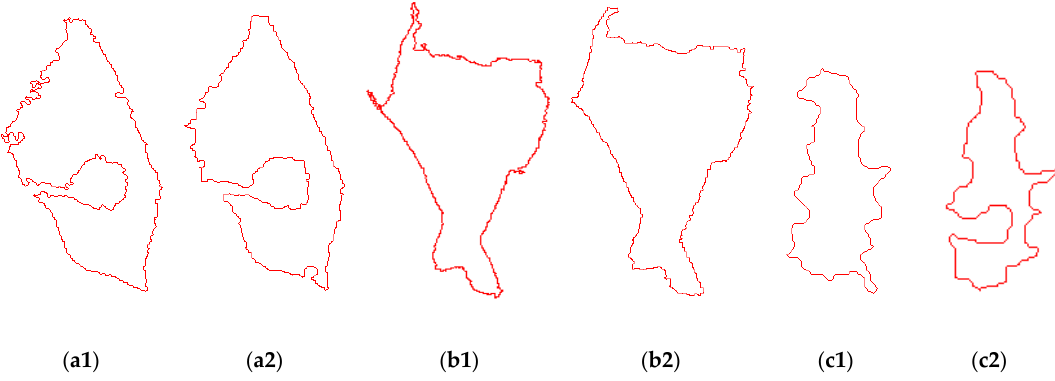
Figure 6. The example for incomplete contours of the same object in different images. ( a1 ) and ( a2 ), ( b1 ) and ( b2 ), ( c1 ) and ( c2 ) are three contour pairs extracted from different images respectively.